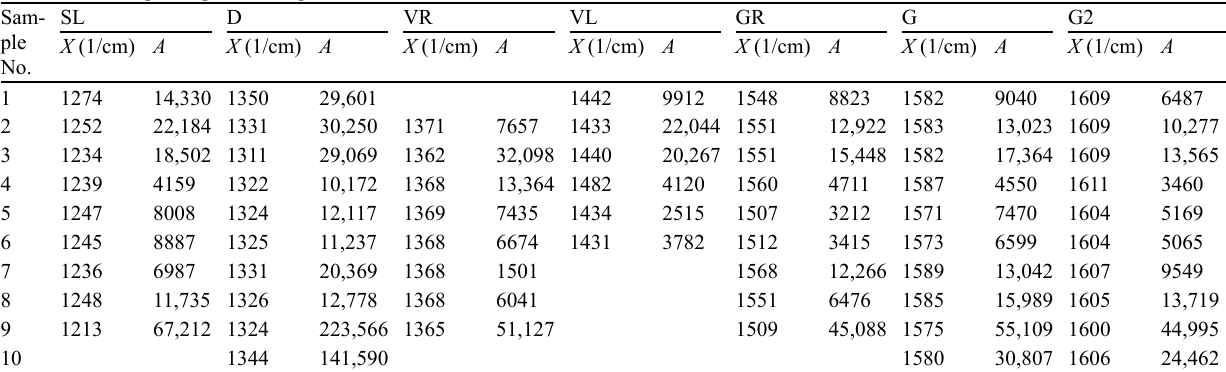
Table 7 Raman spectra peaks fitting data Sam- ple